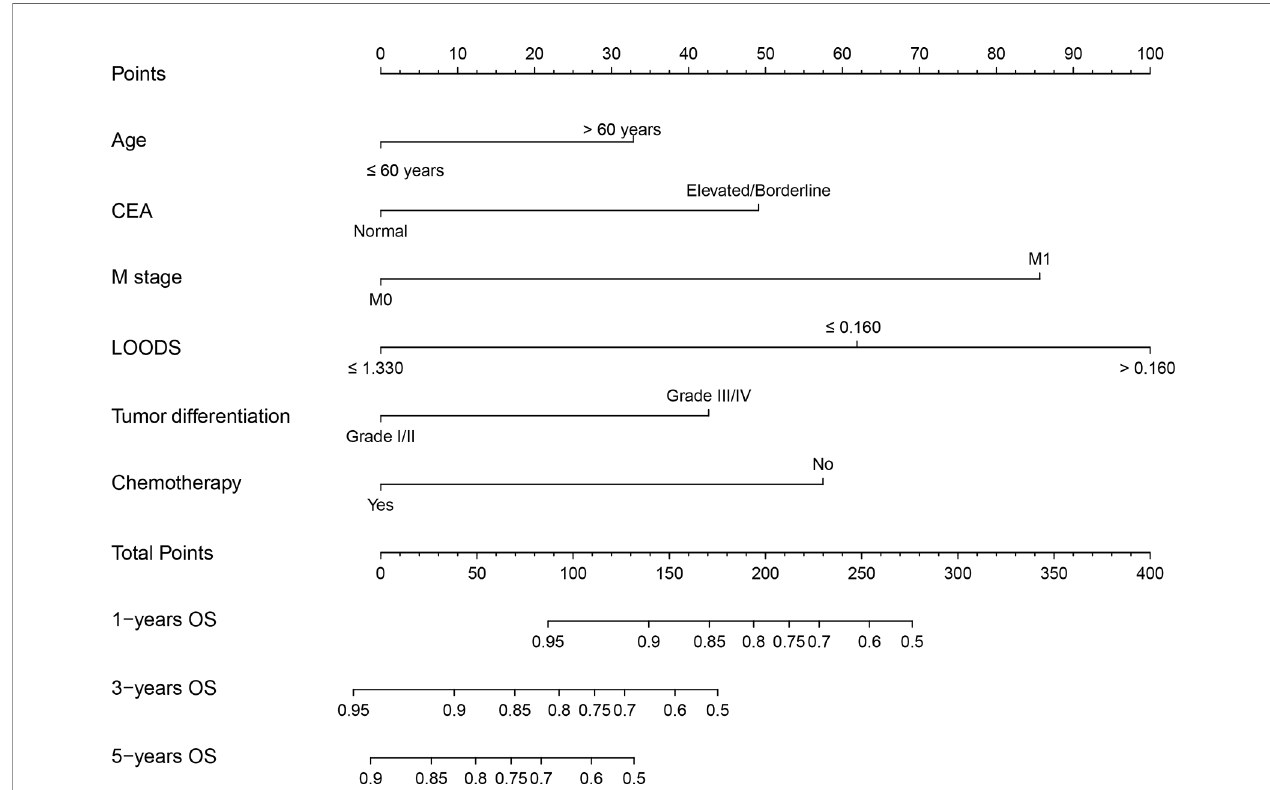
FIGURE 2 | Nomogram for predicting overall survival (OS) of rectal cancer patients with tumor deposits. CEA, carcinoembryonic antigen; LOODS, log odds of metastatic lymph